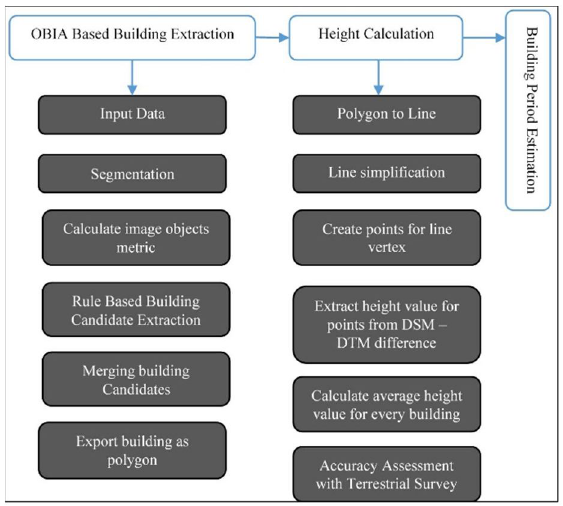
Figure 2. Applied methodology in this study